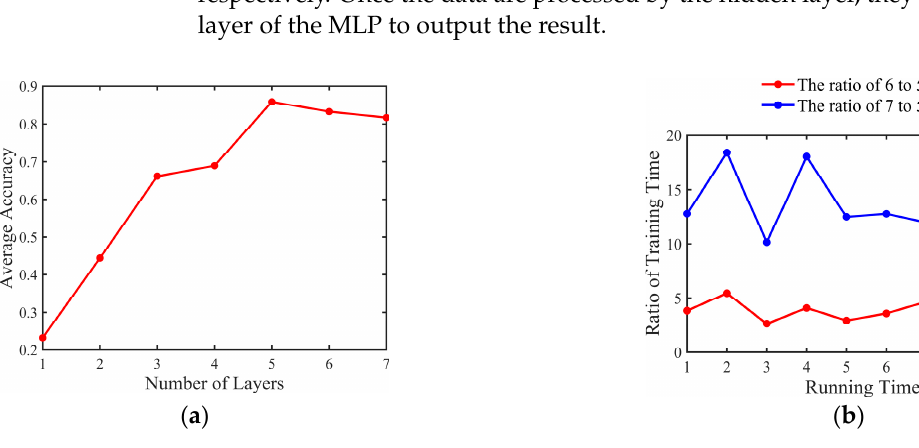
Figure 8. ( a ) Accuracy of multilayer perceptron with di ff erent numbers of layers; ( b ) ratio of training time of 7-hidden-layer and 6-hidden-layer to 5-hidden-layer network, respectively.